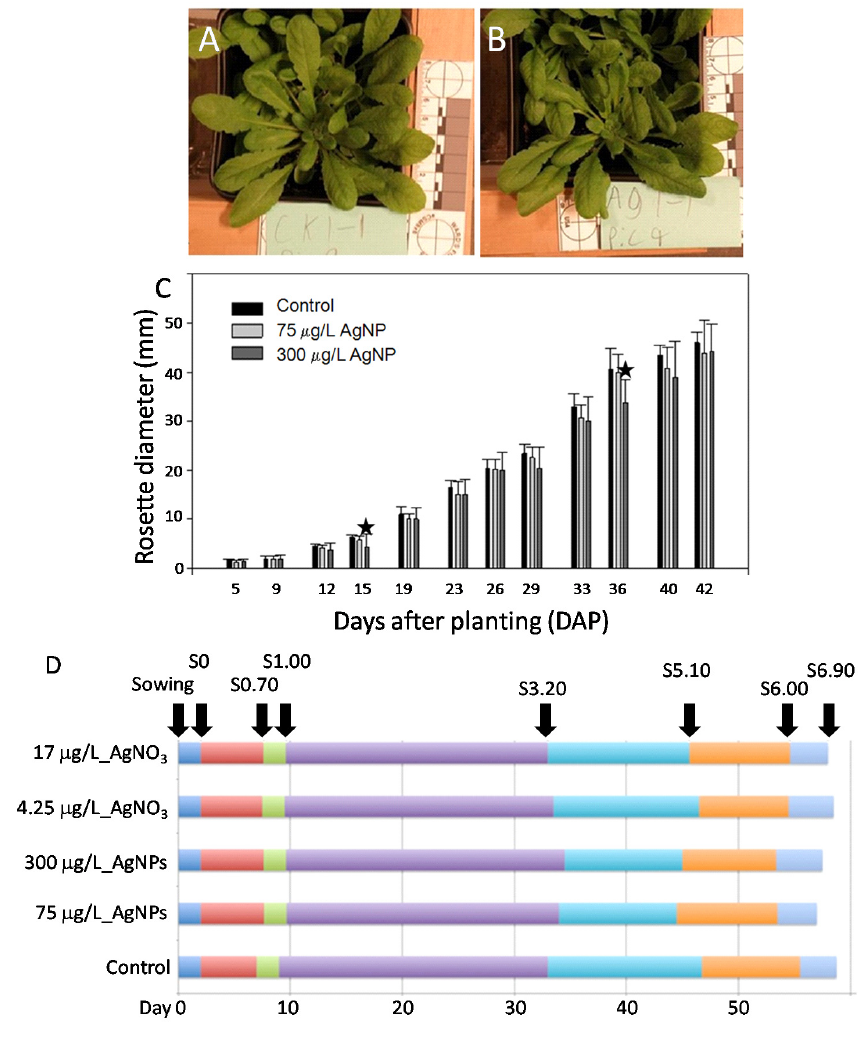
Figure 1. Study of life history traits of Arabidopsis plants irrigated with ddH 2 O or with AgNPs. ( A , B ) Morphology of Arabidopsis rosette leaves growing in potted soil. ( A ) Control plants irrigated with ddH 2 O; ( B ) treated plants with 75 μ g/L of 20 nm AgNPs. ( A ) and ( B ) were at S3.50. ( A ) and ( B ) showed no distinct and visual differences. ( C ) Growth of aboveground vegetative parts of control and AgNP-treated within 42 days after planting (DAP). ( D ) Chronological progression of control, AgNPs-treated (both 75 and 300 μ g/L) and AgNO 3 -treated (4.25 and 17 μ g/L) plants from sowing to